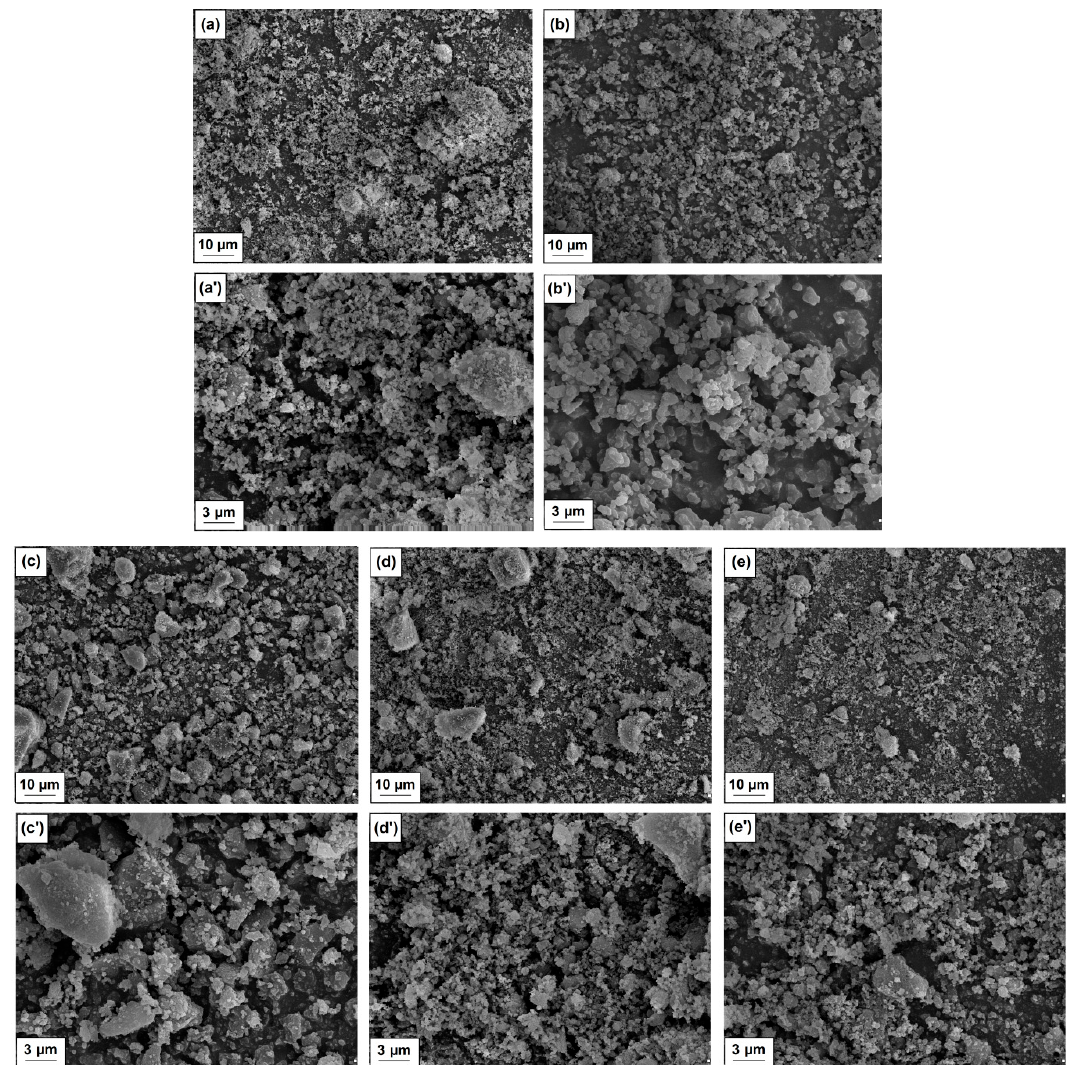
Figure 3. Scanning electron microscope (SEM) images of MgO ( a and a’ ), lignin ( b and b’ ), MgO-lignin hybrid materials with a weight ratio equal to 1:5 wt./wt. ( c and c’ ), 1:1 wt./wt. ( d and d’ ) and 5:1 wt./wt. ( e and e’ ).